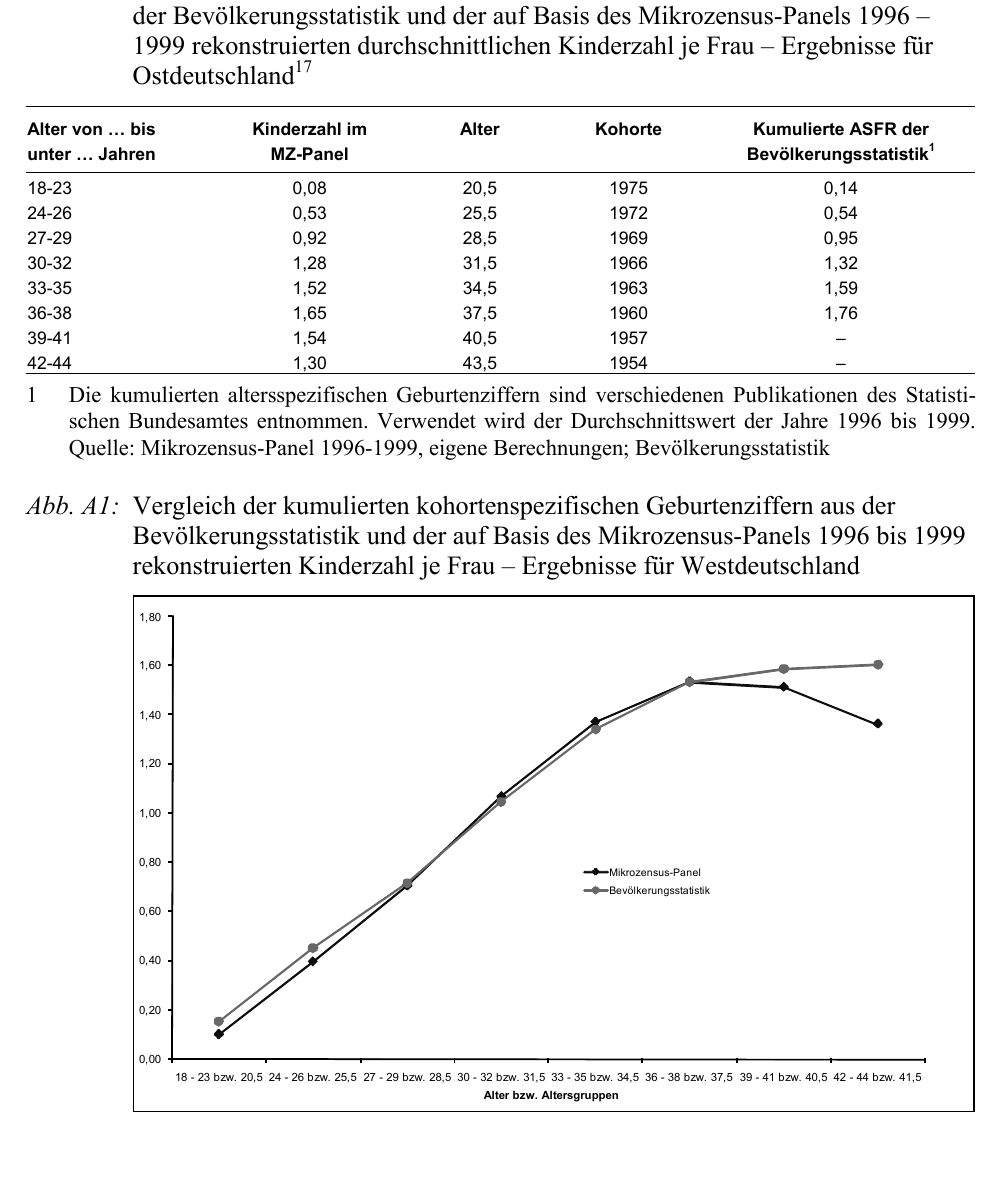
17 Für die neuen Länder liegen für die älteren Jahrgänge vor 1960 keine Zahlen aus der Bevölkerungs- statistik der ehemaligen DDR vor; deshalb müssen diese Jahrgänge bei dem Vergleich